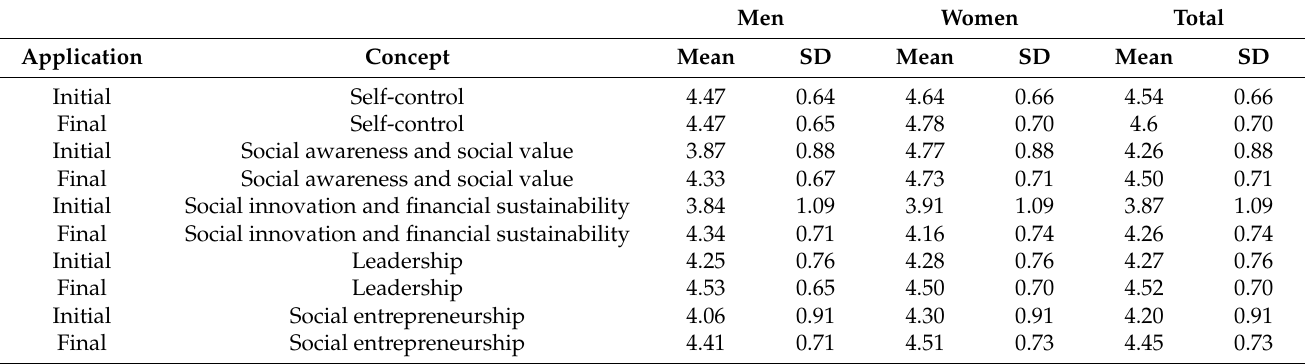
Table 4. Results of the social entrepreneurship competency and its sub-competencies (Initial to Final).